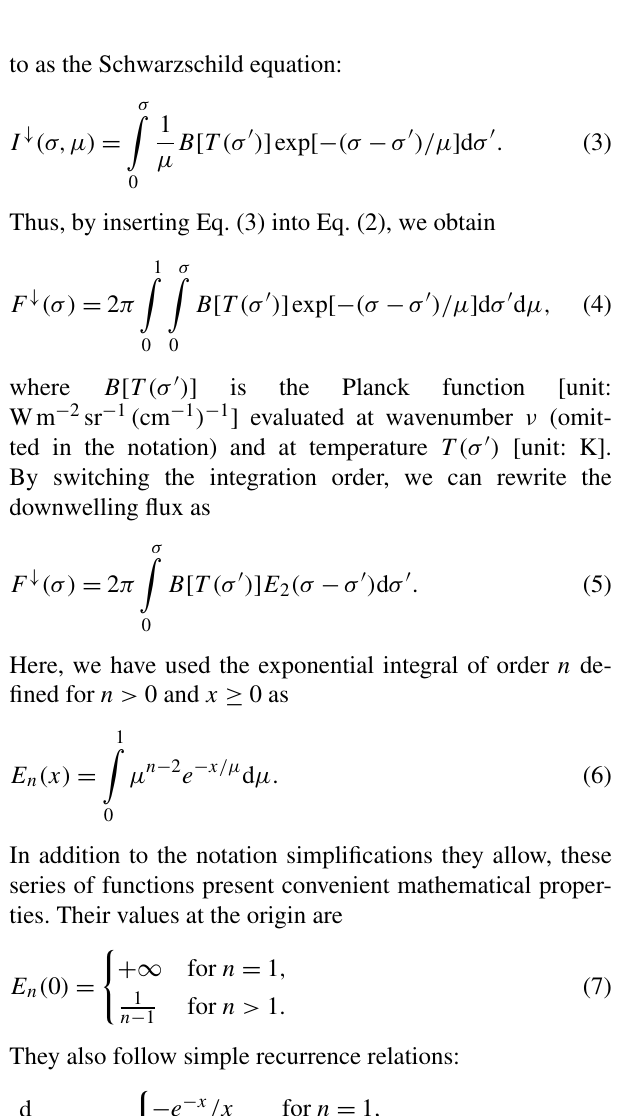
Figure 1. 4A/OP and 4A-Flux flowchart. P , T , and ρ are the pressure grid, the temperature profile, and the profiles of gas concentrations,